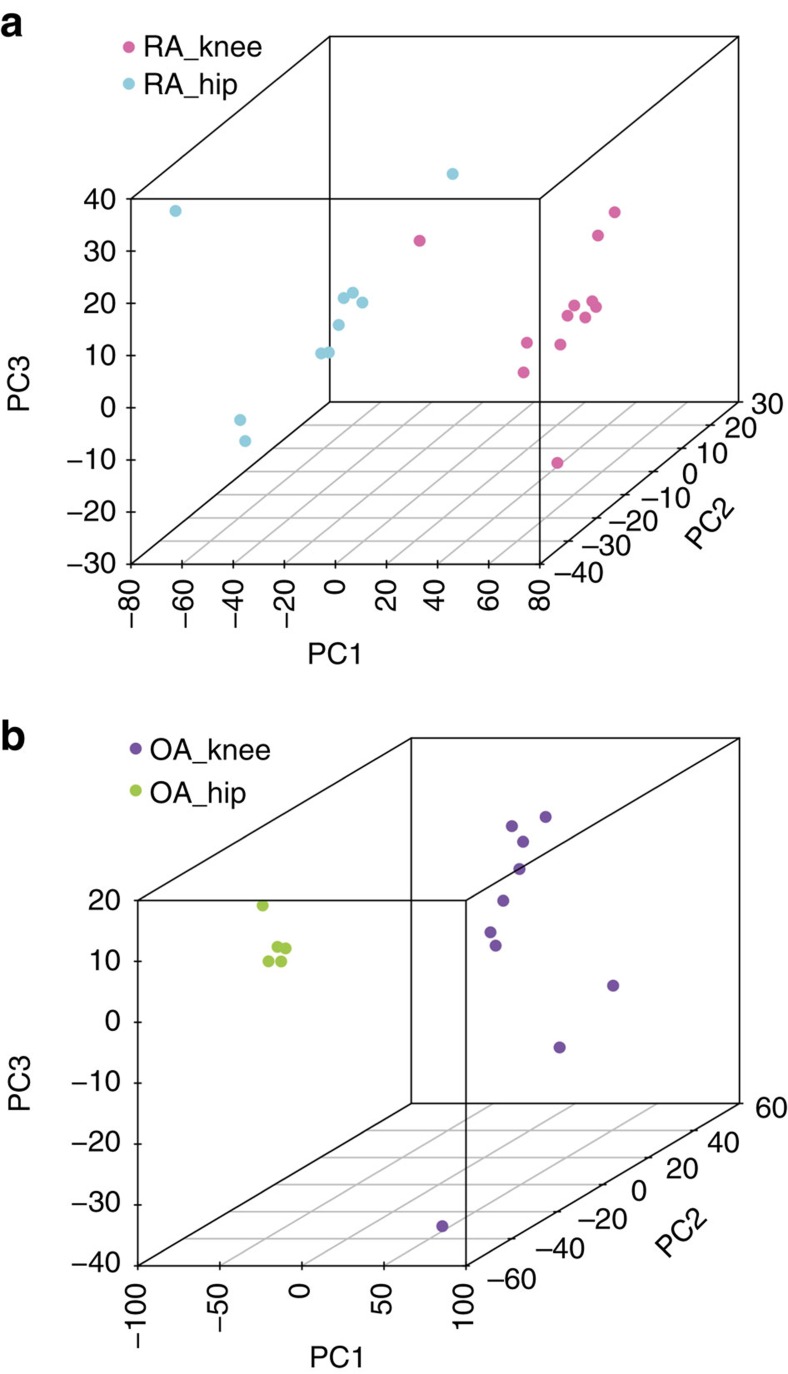
PCA of RA and OA joints by knee or hip methylation signatures.(a) Separation of RA knee and RA hip FLS using 3,739 DMLs. (b) Separation of OA knee and OA hip using the 6,416 DMLs. See text for description of how these DMLs were identified.